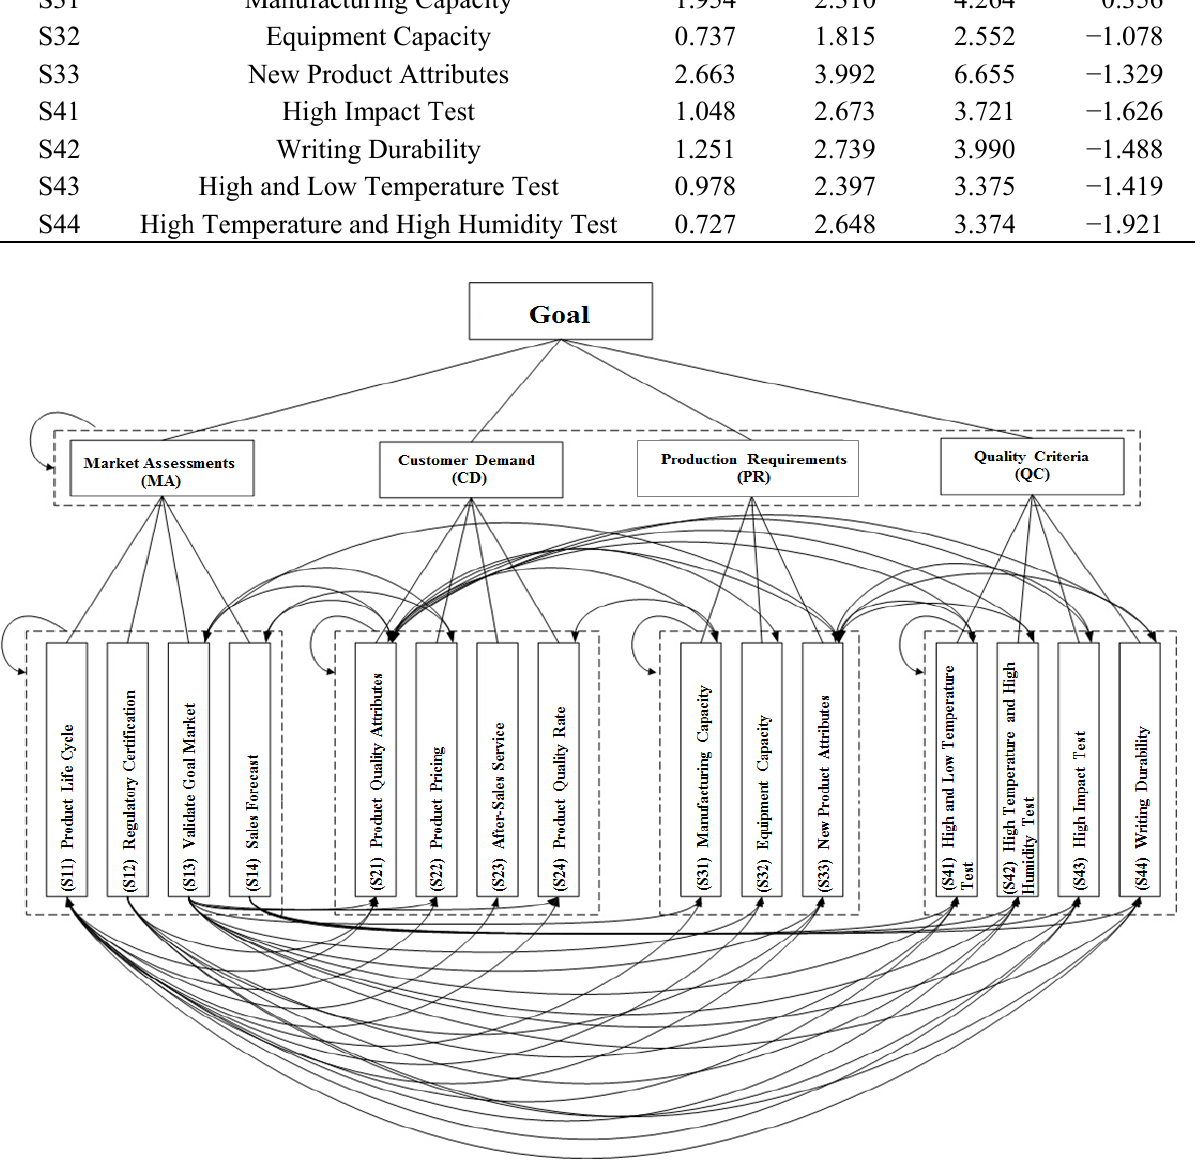
Figure 2. TFT-LCD NPD Performance Evaluation